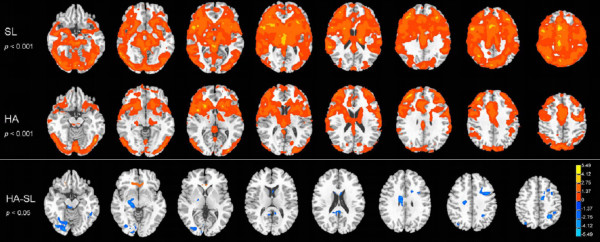
CVR in both groups as well as group comparison. The HA group generally showed decreased CVR. Clusters showing significant group differences are displayed in the third row with blue color indicates decreased cereborvascular reactivity among the HA group and red color indicates increase.